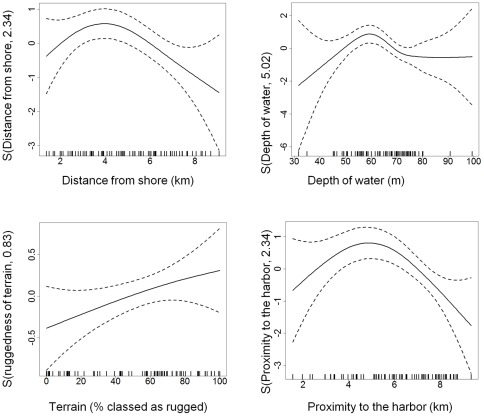
Plots to show the non linear effects of environmental variables on levels of habitat use in female-calf humpback whale groups along the eastern shoreline of the Au'au Channel, Maui, Hawaii.